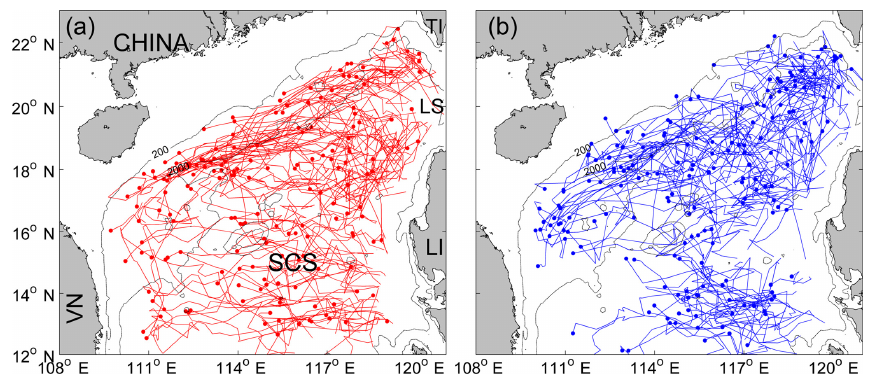
Figure 1. The trajectories of (a) anticyclonic and (b) cyclonic eddies with lifetime ≥ 5 weeks in the northern South China Sea (NSCS). The solid circle represents the ending position of each trajectory. In (a) , TI: Taiwan Island, LI: Luzon Island, LS: Luzon Strait, VN: Vietnam. The two isobaths are for 200 and 2000m,